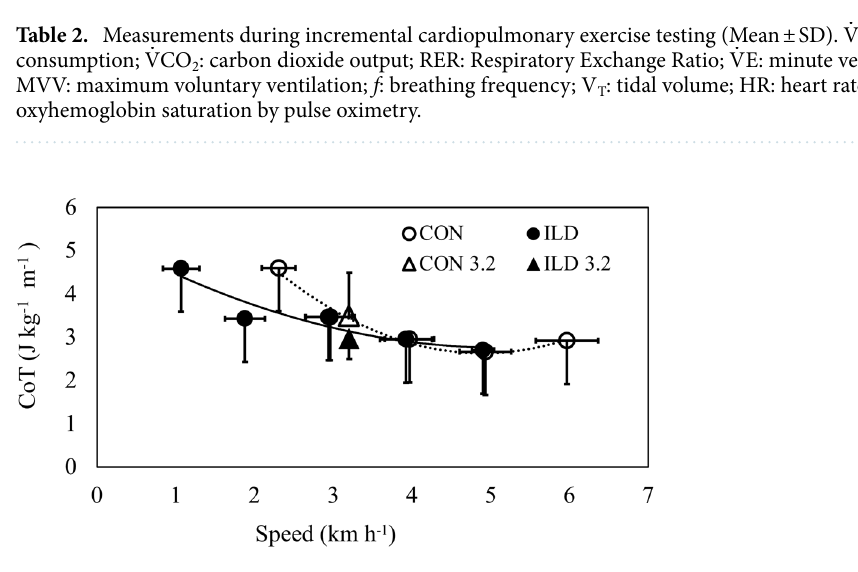
Table 2. Measurements during incremental cardiopulmonary exercise testing (Mean ± SD).